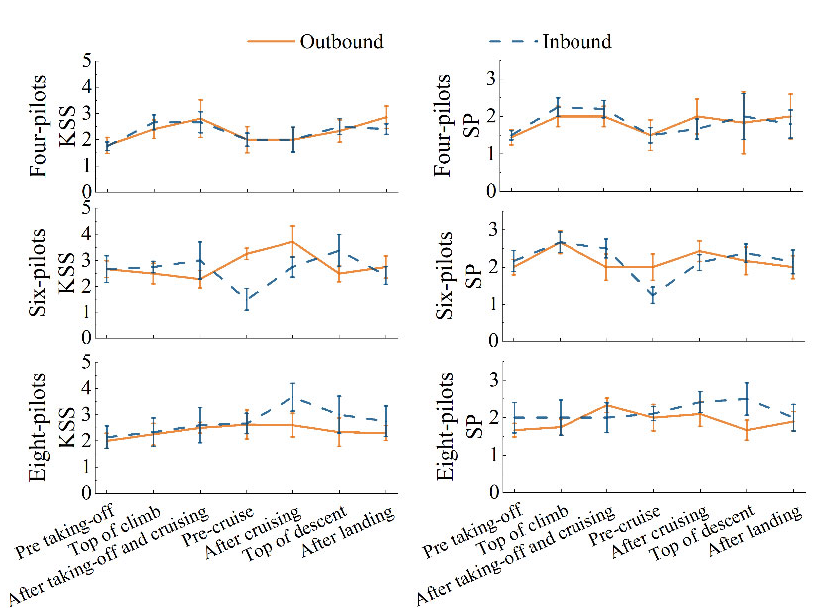
Figure 4. Subjective self ‐ assessment of all